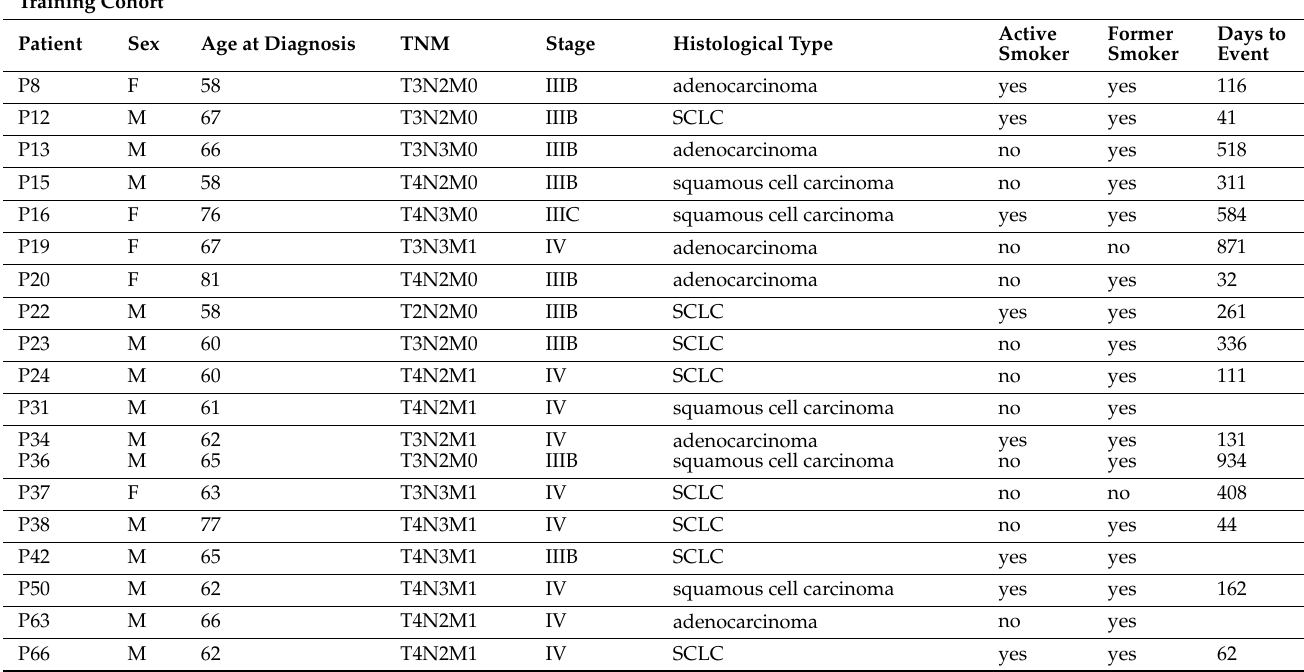
Table 2. Individual clinicopathological characteristics of the 64 patients included in both